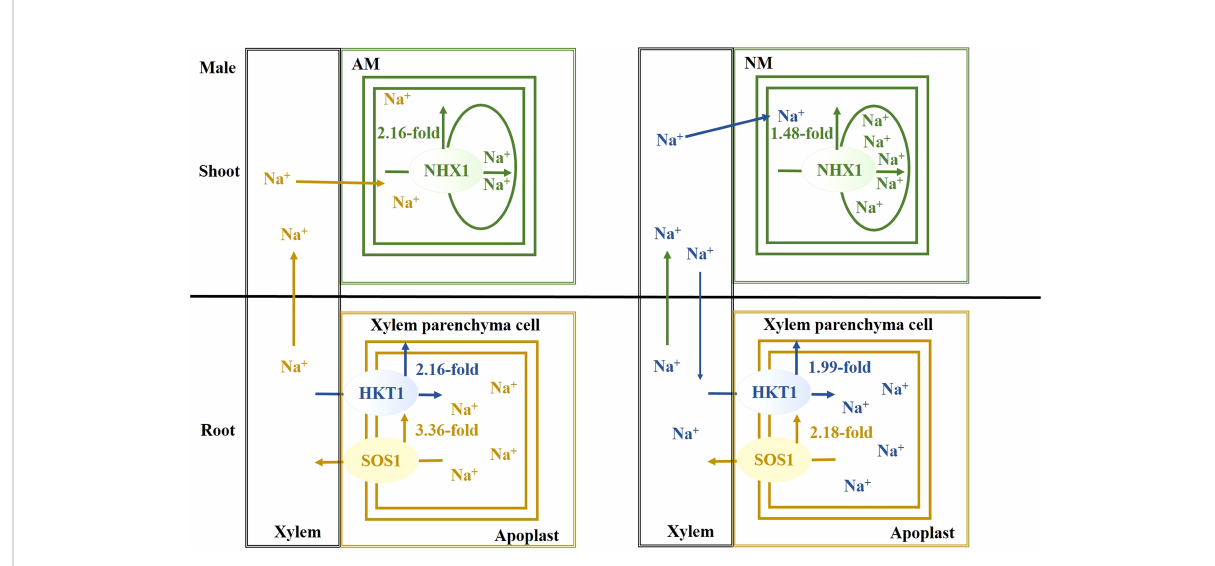
FIGURE 6 The schematic model for Na + transporters regulating Na + homeostasis for males.